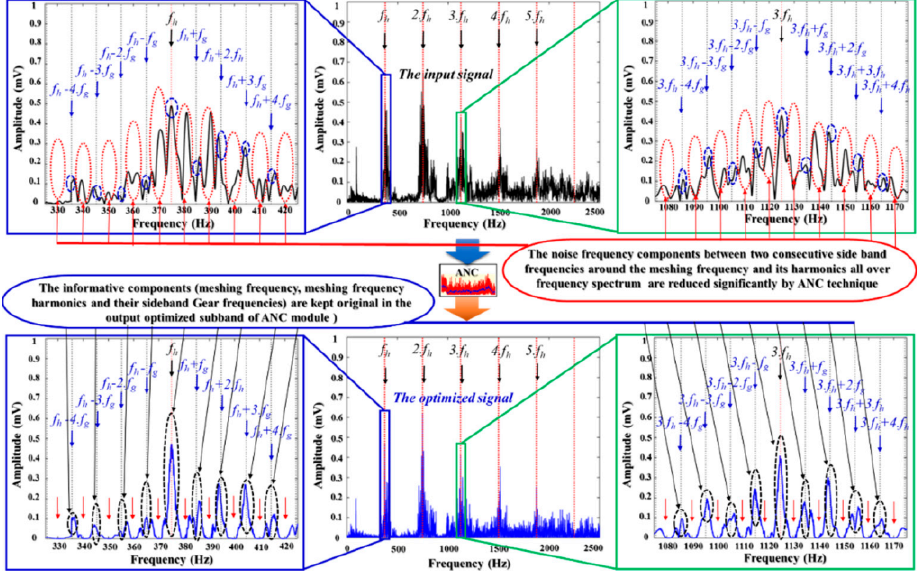
Figure 13. Frequency spectrum analysis of the vibration subband (for fault state D2 at 900 RPM) in the comparison between an input and output subband of the ANC